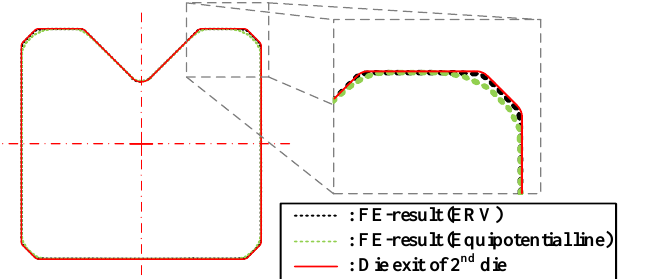
Figure 12. Comparison of the cross-sectional shapes of the second pass for the cross-roller guide.